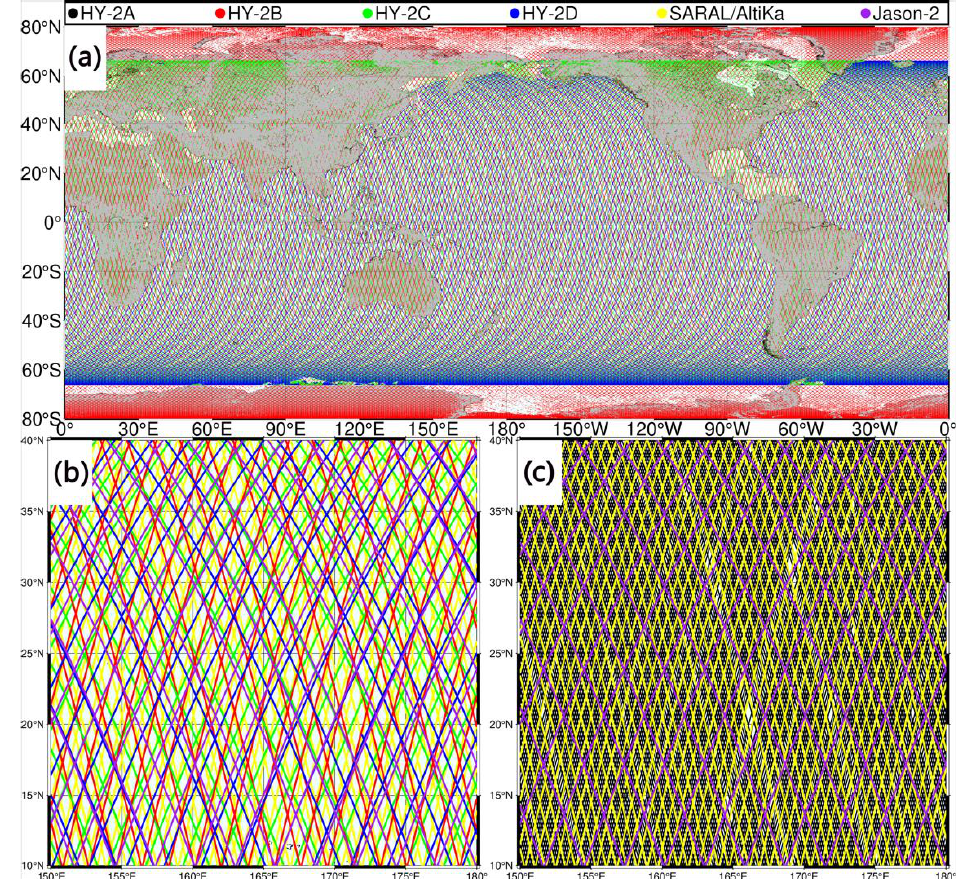
Figure 2. Global distribution of HY-2 altimetry data and magnification in a 30 ◦ × 30 ◦ region (Region 1, North Pacific; ( a ): global distribution of one complete ERM cycle from HY-2B (red), HY-2C (green) and HY-2D (blue); ( b ): regional distribution of one complete ERM cycle from HY-2B (red), HY-2C (green), HY-2D (blue), SARAL/AltiKa (yellow) and Jason-2 (purple) in Region 1; ( c ): regional distribution of one complete GM cycle from HY-2A (black) and one complete ERM cycle from SARAL/AltiKa (yellow) and Jason-2 (purple) in Region